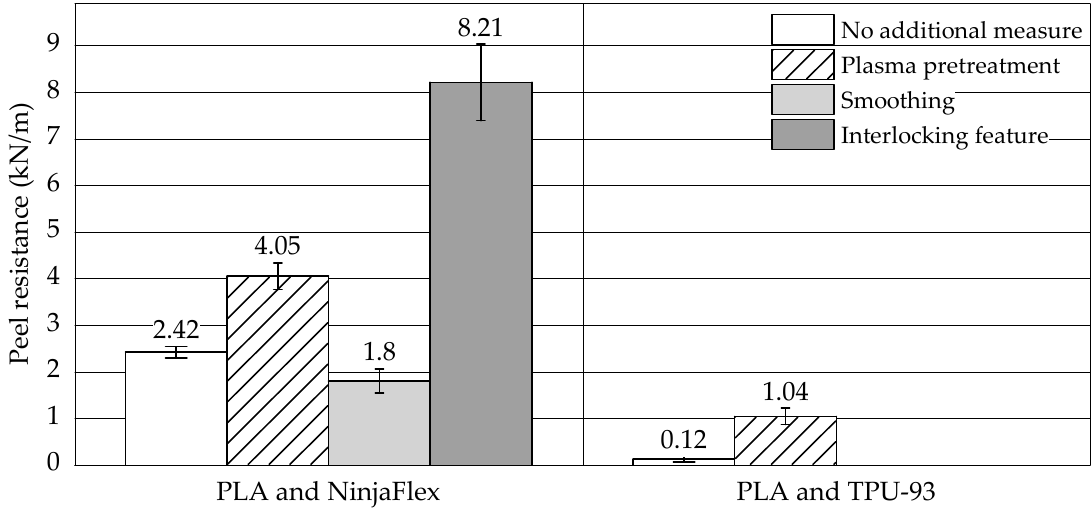
Figure 10. Comparison of di ff erent additional measures in order to increase the interface strength of selected material combinations.